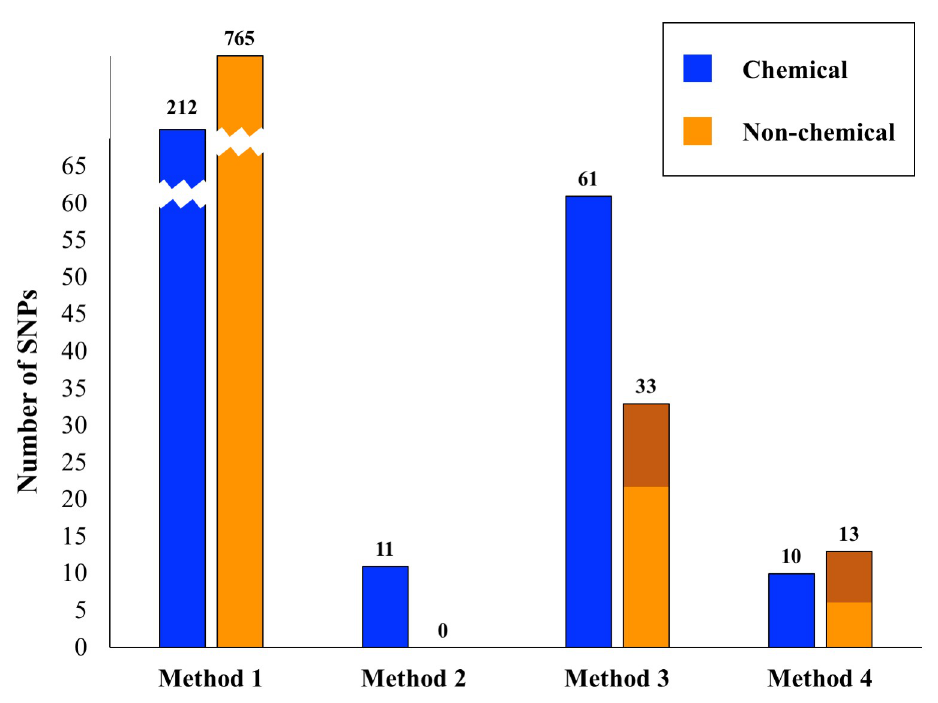
Fig 1. Significant SNPS relative to analytical method. Shown are the numbers of significant SNP associations for the four methods outlined in the text. For Method 1 the bars are broken for convenience of display. The number of significant SNPs for each Method/category combination is given above its respective bar. The dark orange shading for Methods 3 and 4 in the non-chemical category indicates the number of SNPs significant for the subcategory ‘growth